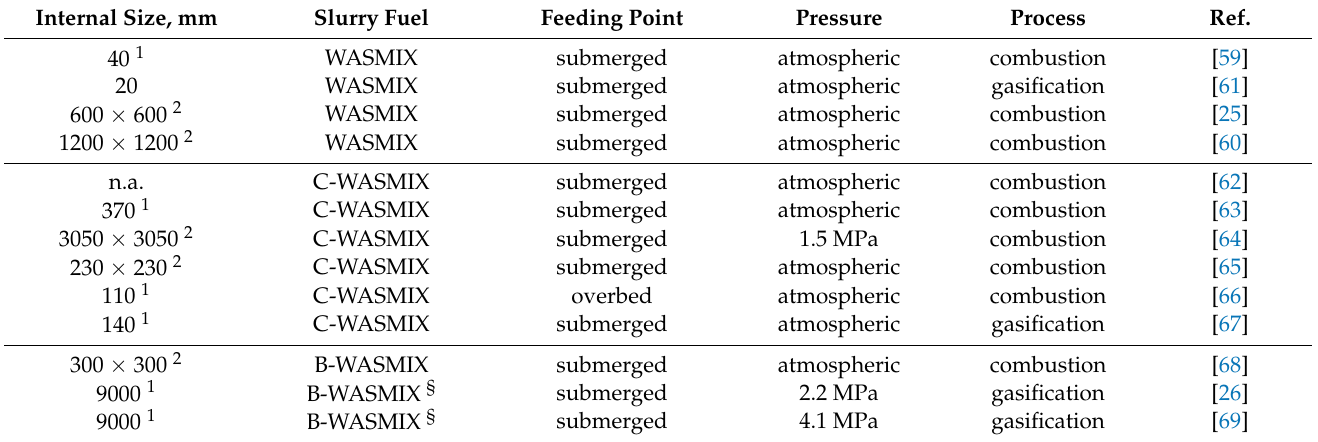
Table 3. Investigations on waste derived mixtures in a fluidized